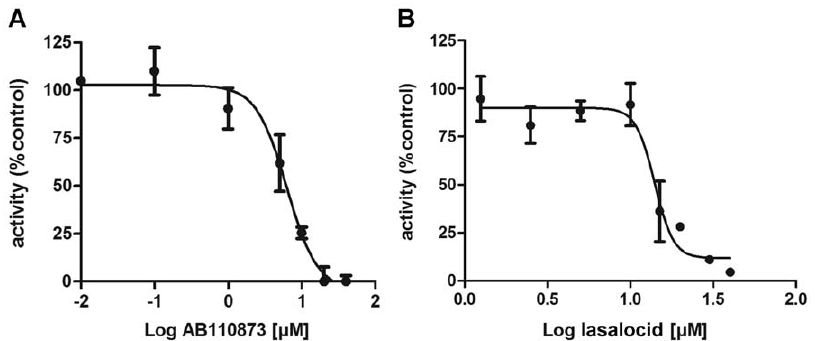
Figure 3. Inhibition of human 11 b -HSD2 by AB110873 and lasalocid. Concentration-dependent inhibition of 11 b -HSD2 by the silane- coupling agent AB110873 ( A ) and the anti-biotic lasalocid ( B ) measured in cell lysates of stably transfected HEK-293 cells. Data represent mean 6 SD from three independent experiments.